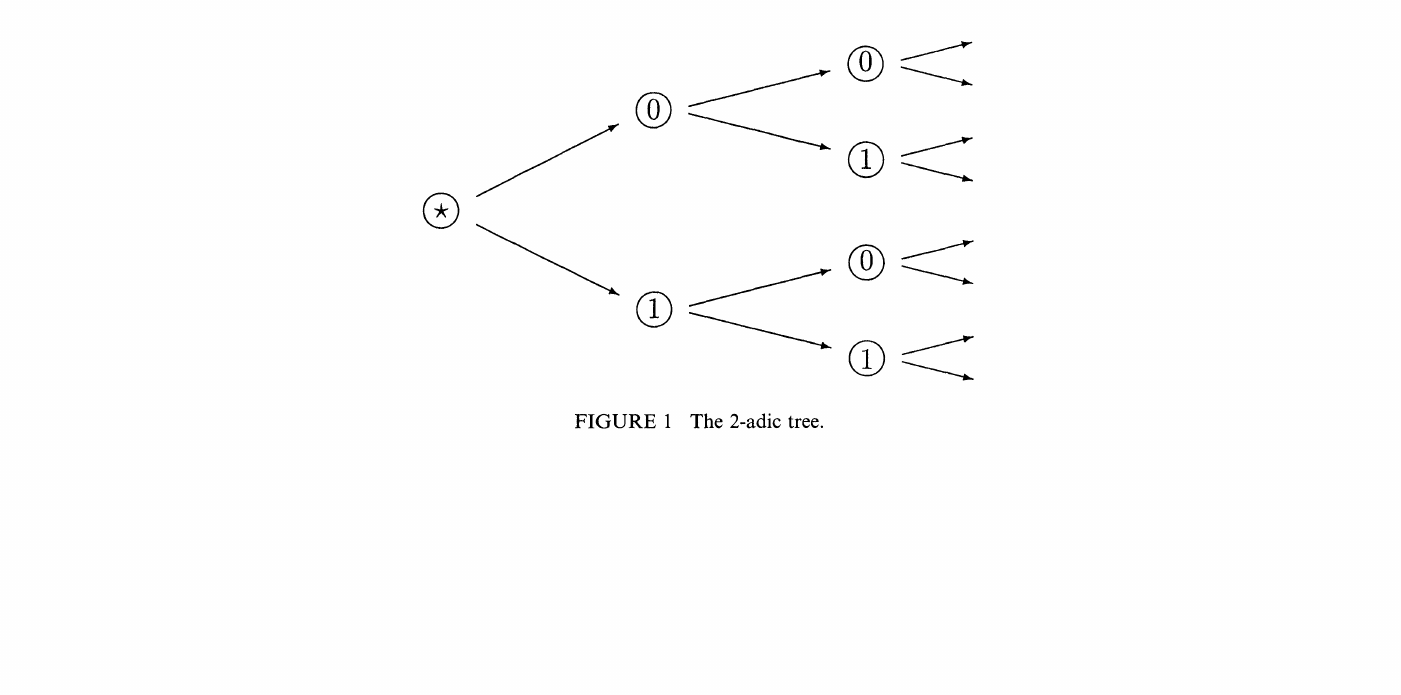
FIGURE The 2-adic